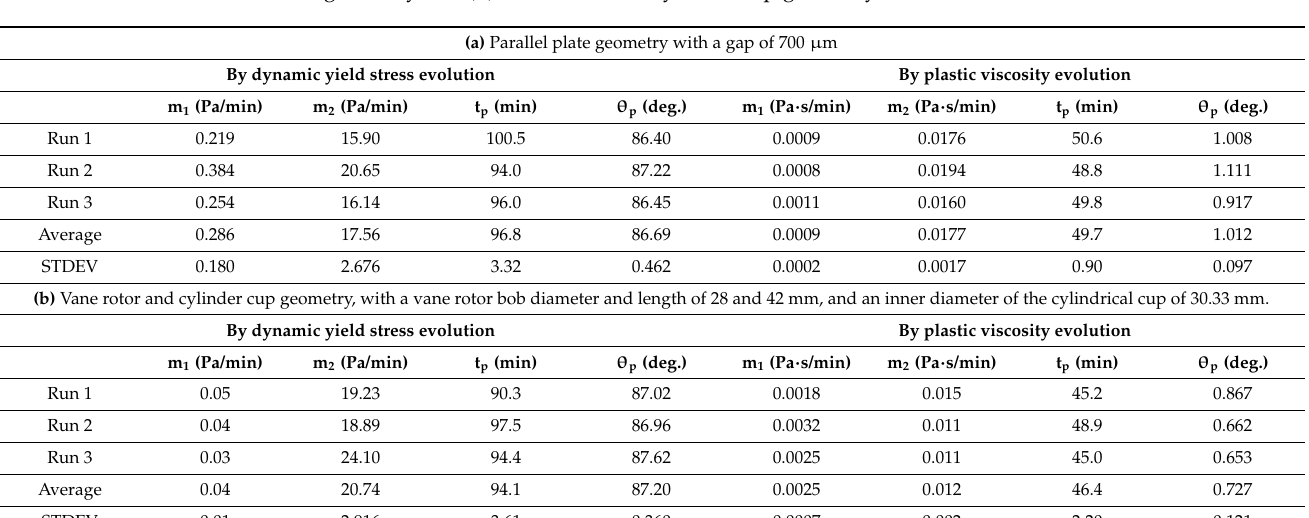
Figure 8. Time-dependent dynamic yield stress and plastic viscosity evolution obtained with: ( a , b ) parallel plate geometry with a gap of 700 µm, and ( c , d ) vane rotor and cylinder cup geometry, respectively. Table 3. Results from dynamic yield stress and plastic viscosity-based tests, using (i) parallel plate geometry and (ii) vane rotor and cylinder cup